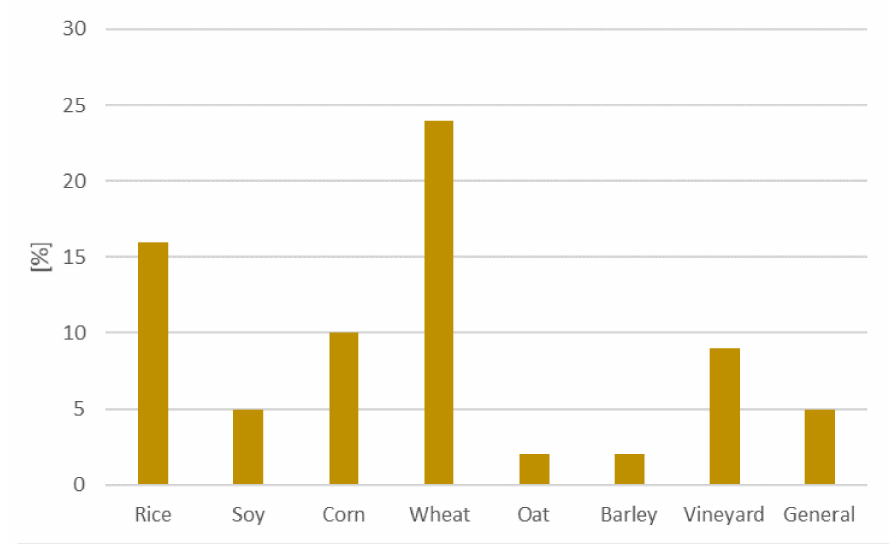
Figure 13. Percentage of the number of studies focused on different types of crops in the analyzed set of